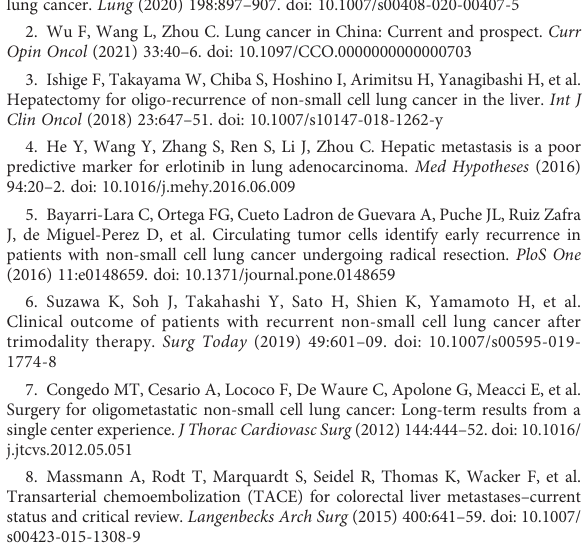
SUPPLEMENTARY FIGURE 1 Correlation of extrahepatic metastasis with PFS (A) and Correlation of extrahepaticmetastasisandtumorsizewithsurvival.OS (B) ;associationof tumor size with PFS (C) and OS (D) . PFS, progression-free survival; OS, overall